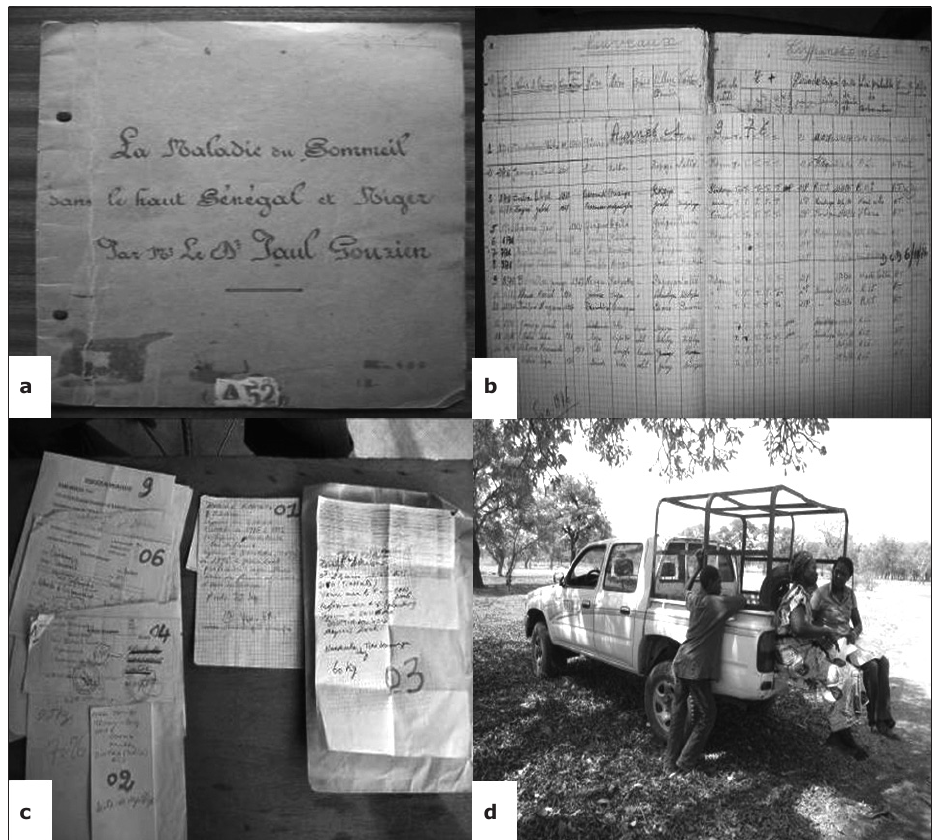
Figure 1. – (a) Rapport original de Paul